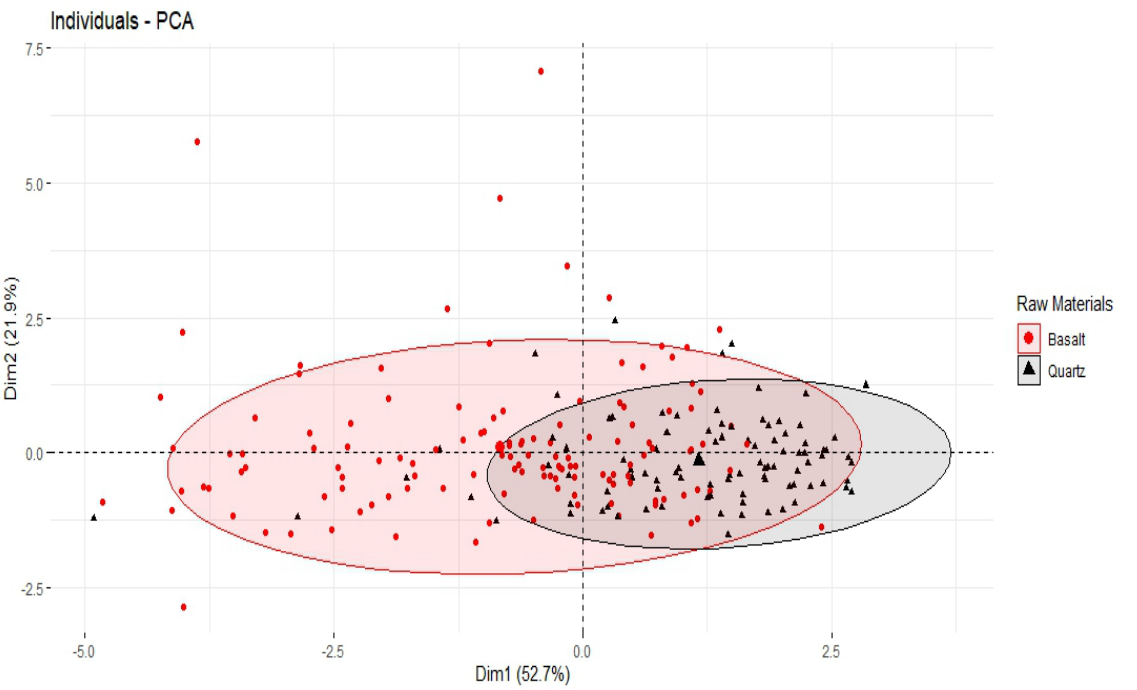
Figure 9. PCA of débitage flakes illustrating the relationship between artefacts of different raw materials and using 95% data capture